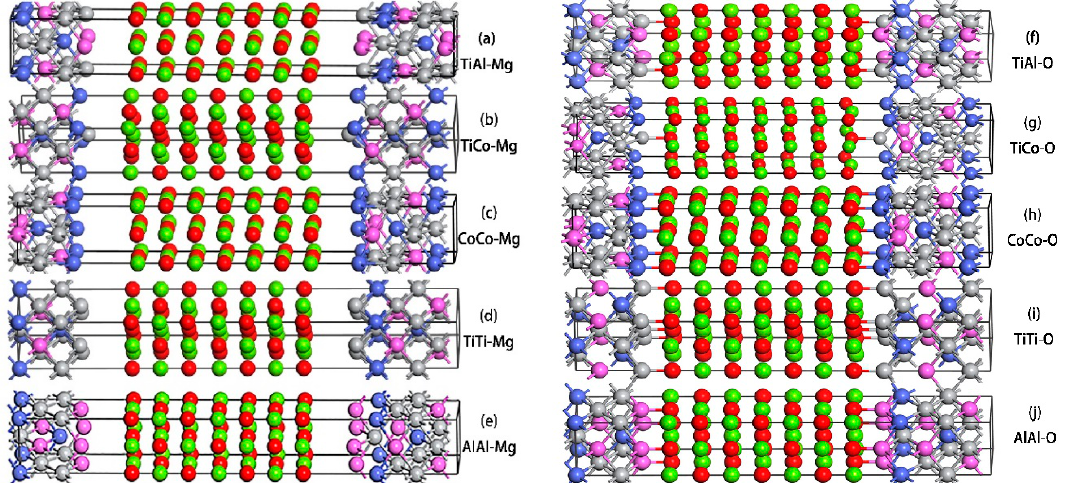
Figure 1. 10 lowest energy terminations in the Ti 2 CoAl/MgO(100) heterojunction after geometry